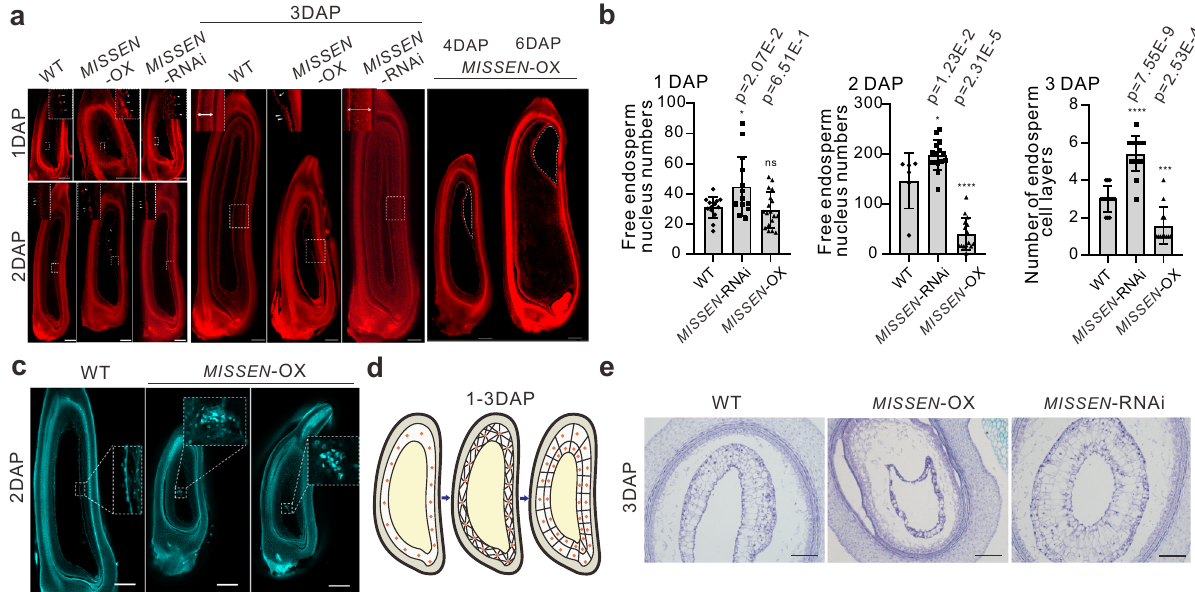
Fig. 2 The lncRNA MISSEN regulates endosperm development. a Confocal laser scanning microscopy of developing caryopses stained with Eosin B in WT, MISSEN -RNAi, and MISSEN -OX plants. The endosperm nuclei were shown in the magni fi ed images. The cavities in MISSEN -OX endosperm at 4 and 6 DAP are indicated by dotted lines. Scale bars, 50 µ m. The experiment was repeated three times with similar results and one representative result was shown. b The number of free endosperm nuclei in WT, MISSEN -RNAi, and MISSEN -OX plants at 1DAP ( n = 14, 14, 18 caryopsis) and 2DAP ( n = 6, 15, 15 caryopsis), and the number of endosperm cell layers in WT, MISSEN -RNAi, and MISSEN -OX plants at 3DAP ( n = 14, 17, 12 caryopsis). Values are the means ± SD. c Confocal micrographs of caryopses at 2 DAP stained with Propidium Iodide in WT, MISSEN -RNAi, and MISSEN -OX plants showing the abnormal nuclei distribution in MISSEN -OX plants. The insets show the enlarged images. Scale bars, 200 µ m. The experiment was repeated three times with similar results and one representative result was shown. d The schematic diagram of endosperm cellularization during 1 – 3 DAP; e Paraf fi n transverse sections of the caryopses at 3 DAP of WT, MISSEN -RNAi, and MISSEN -OX plants. Scale bars, 200 µ m. The experiment was repeated three times with similar results and one representative result was shown. Signi fi cant differences were identi fi ed at the 5% (*), 1% (**), 0.1% (***) and <0.01% (****) probability levels using two-tailed paired t